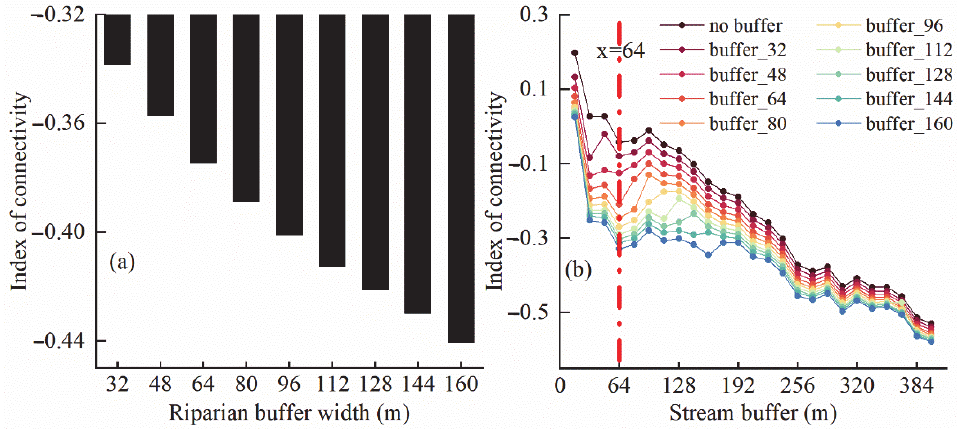
Figure 8. Effect of riparian buffer width ( a ) and distance to stream ( b ) on sediment connectivity.